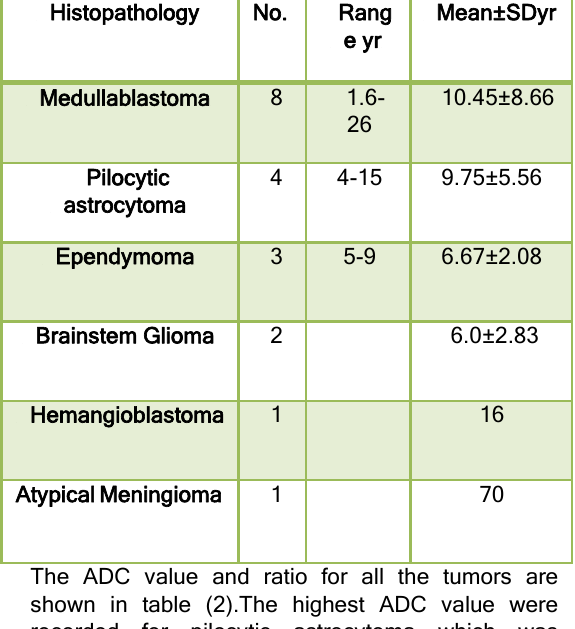
Table ( 1): Age distribution of patients according